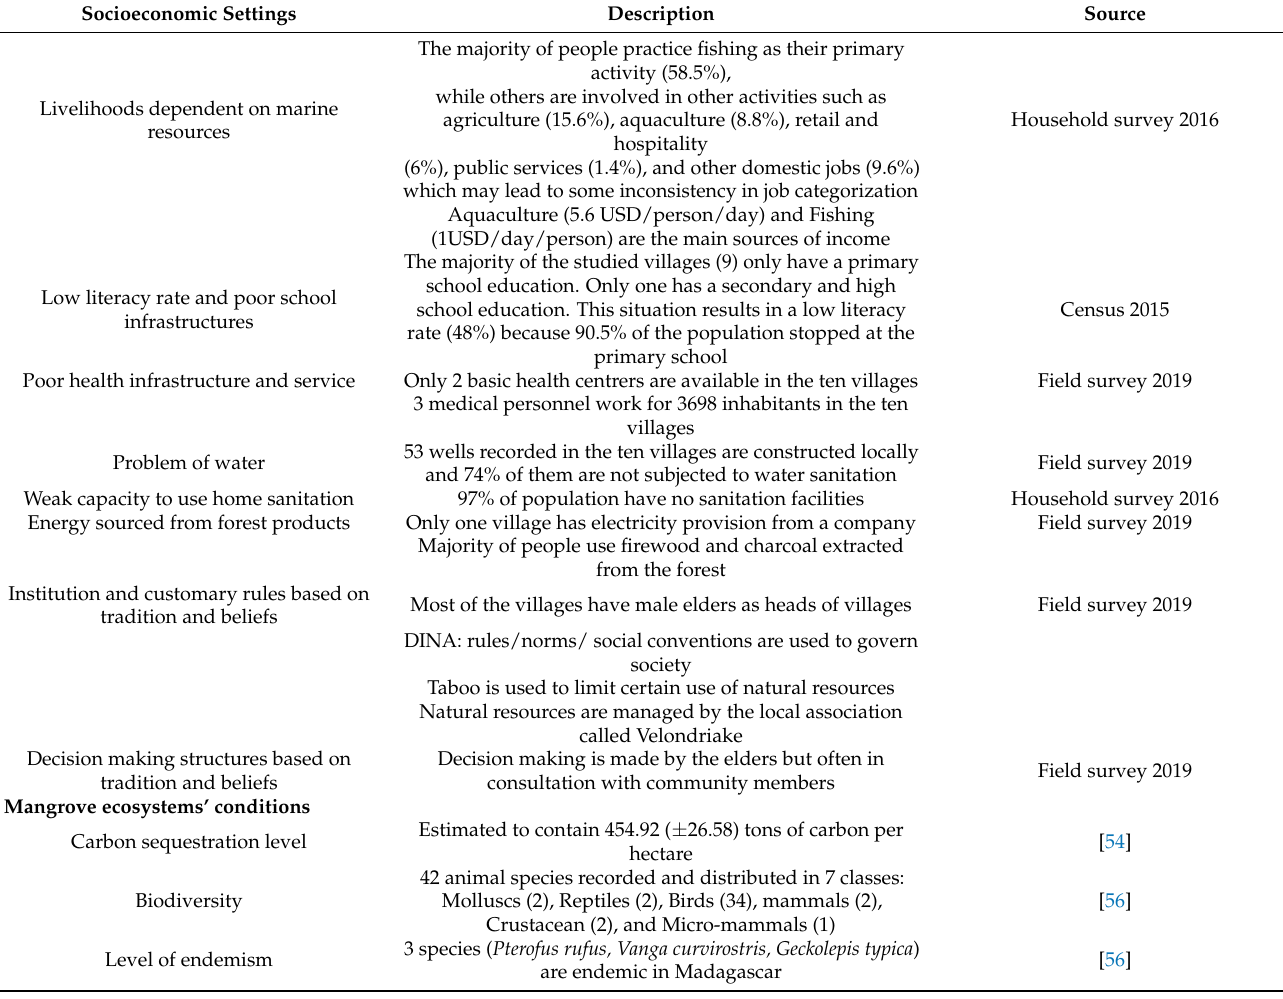
Table 4. Description of socioeconomic and mangrove ecosystem conditions of the Baie des Assassins. Socioeconomic